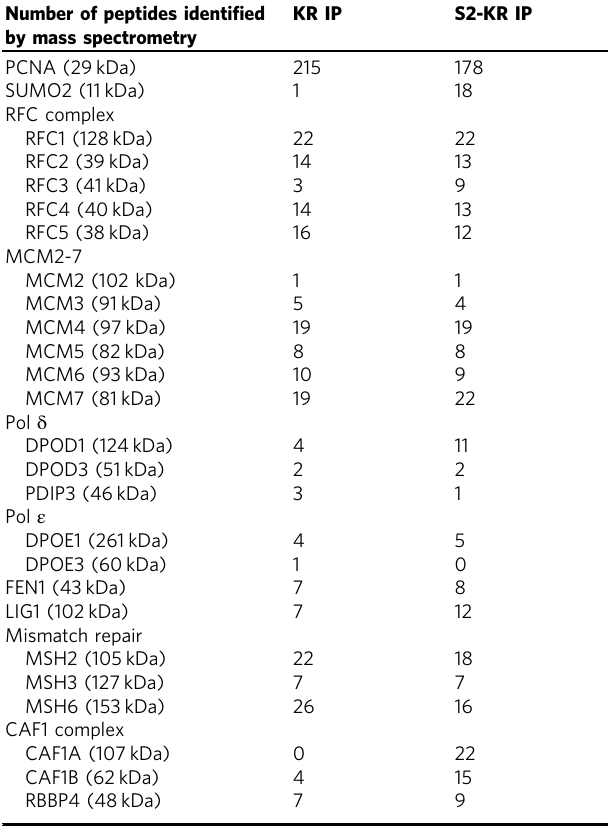
Numbers of peptides detected by mass spectrometry for each of the indicated proteins co- puri fi ed with KR and the S2-KR FLAG – PCNA protein complexes isolated from the chromatin- bound (CB) fractions of HEK293T cells expressing the indicated FLAG-tagged